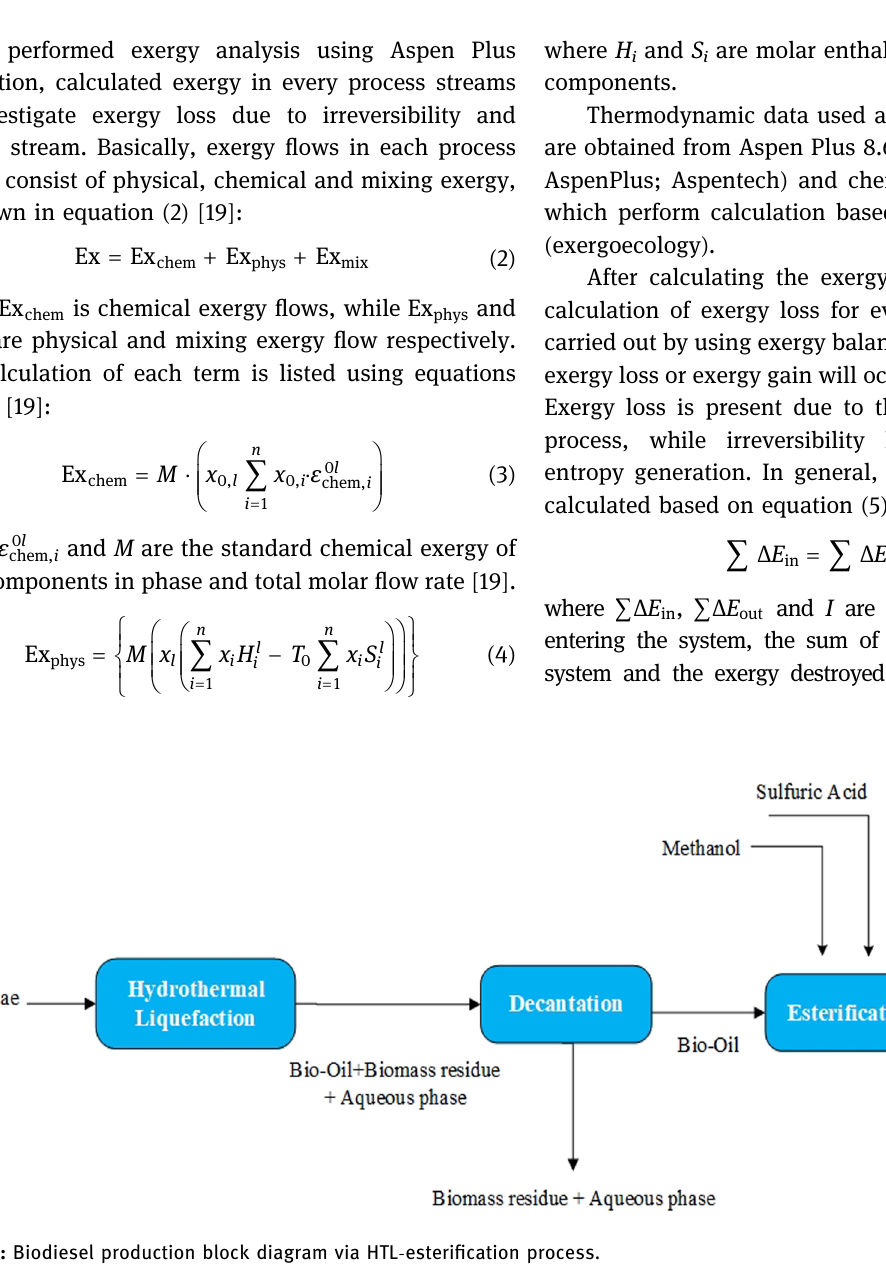
Figure 1: Biodiesel production block diagram via conventional process.